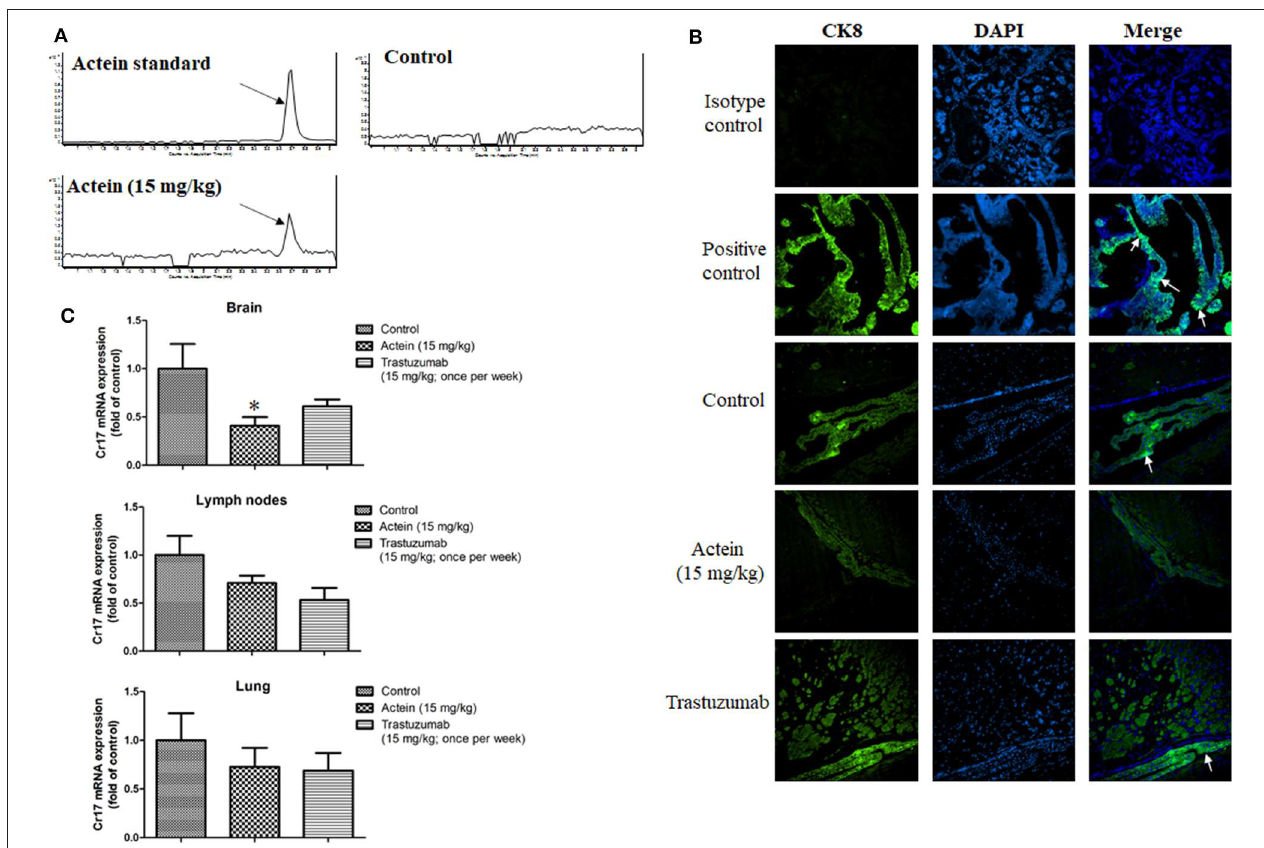
FIGURE 7 | Actein suppressed brain metastasis in MDA-MB-361 cells tail vein injection in SCID mice. (A) LCMS results of actein in brain tissue with arrows showing the peak of actein. (B) Representative images of CK8 staining of brain tissues, arrows showing the metastatic loci. (C) Quantitative RT-PCR analyses of Cr17 gene in brain, lymph nodes and lungs. * p < 0.05 compared with control using One-way